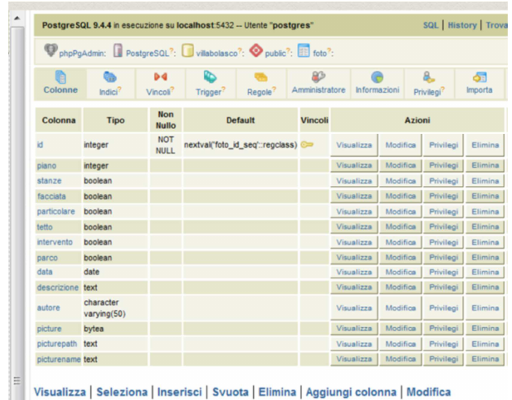
Figure 15: The PhpPgAdmin